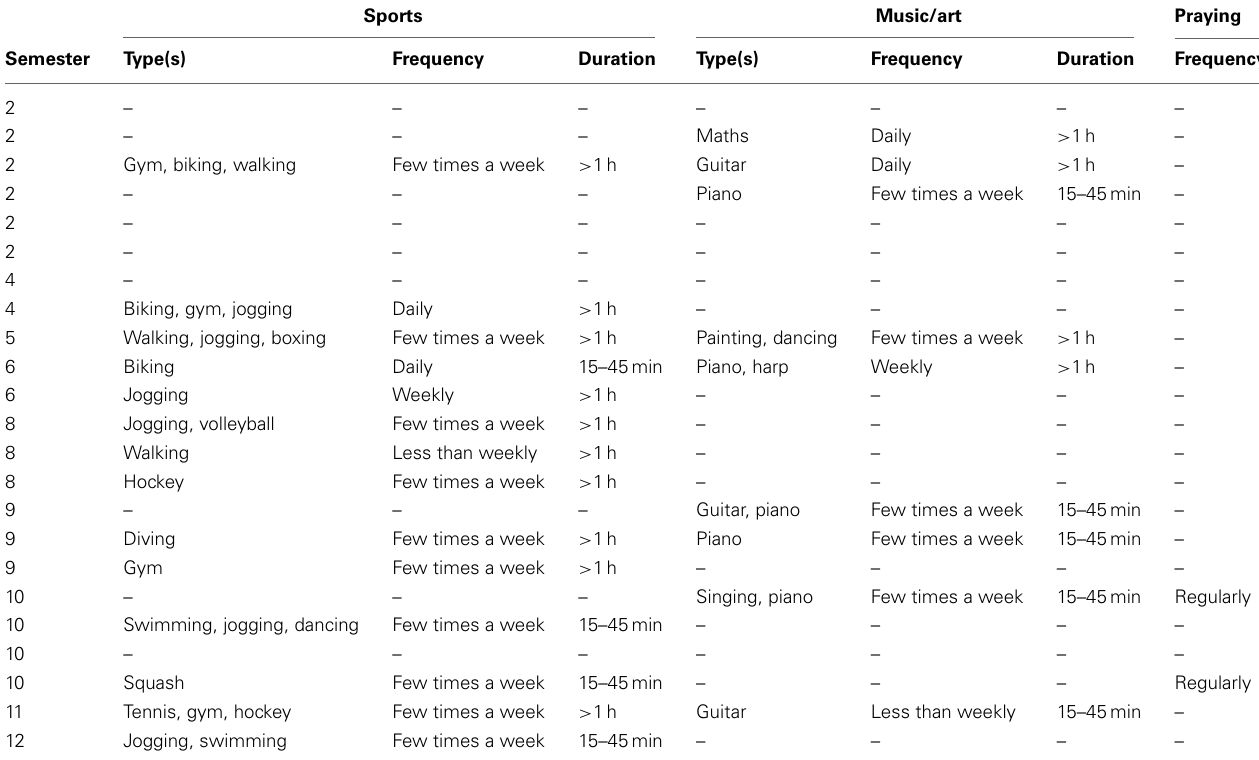
Table 1 | Personal characteristics of the